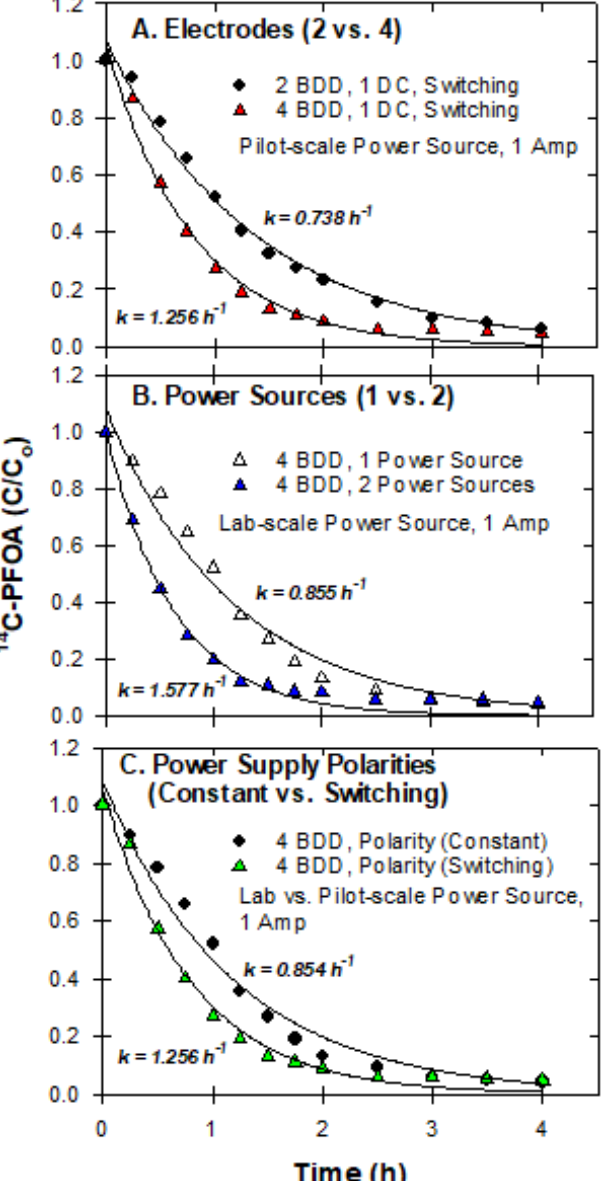
Figure 9. Temporal changes in 14 C-PFOA when treated with 3D printed reactor using: ( A ) 2 versus 4 BDD electrodes; ( B ) 1 versus 2 power sources; and ( C ) constant versus switching polarities.